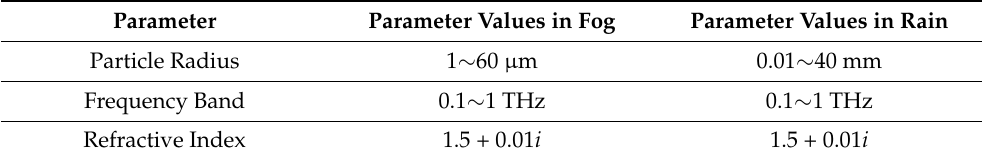
Table 2. Simulation parameters based on Mie theory.